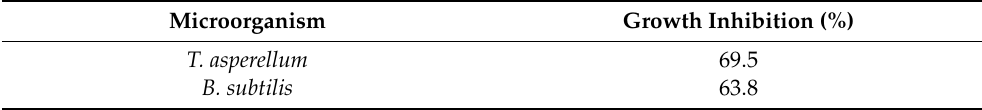
Table 1. Inhibition of the Rhizoctonia sp. growth by the microorganisms T. asperellum and B. subtilis under in vitro conditions.